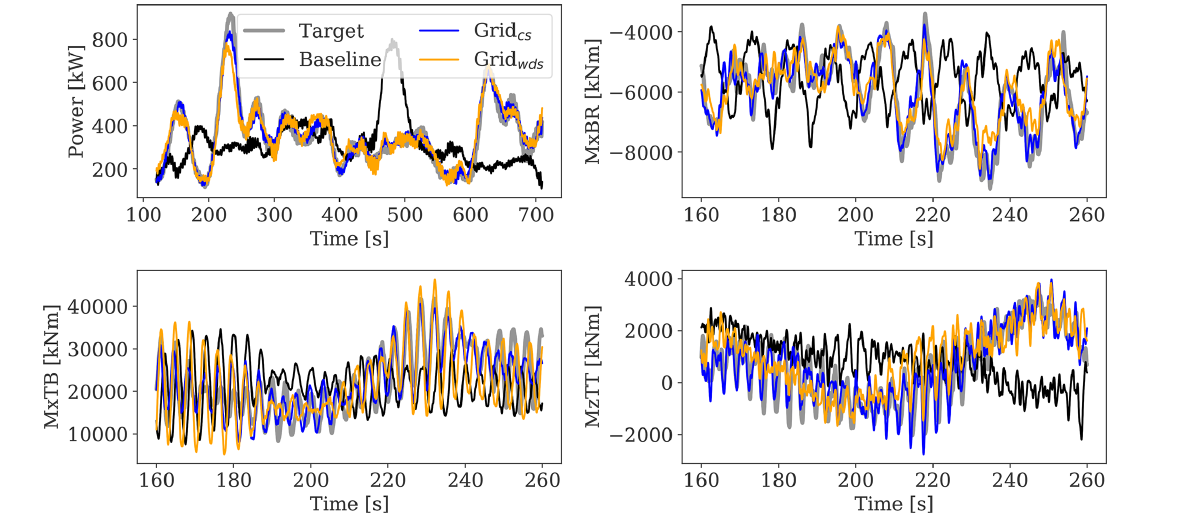
Figure 13. Comparison of predicted load time series based on aeroelastic simulations carried out with the target, baseline, and CS- and WDS-reconstructed fields. The lidar-based fields are reconstructed using the Grid pattern.